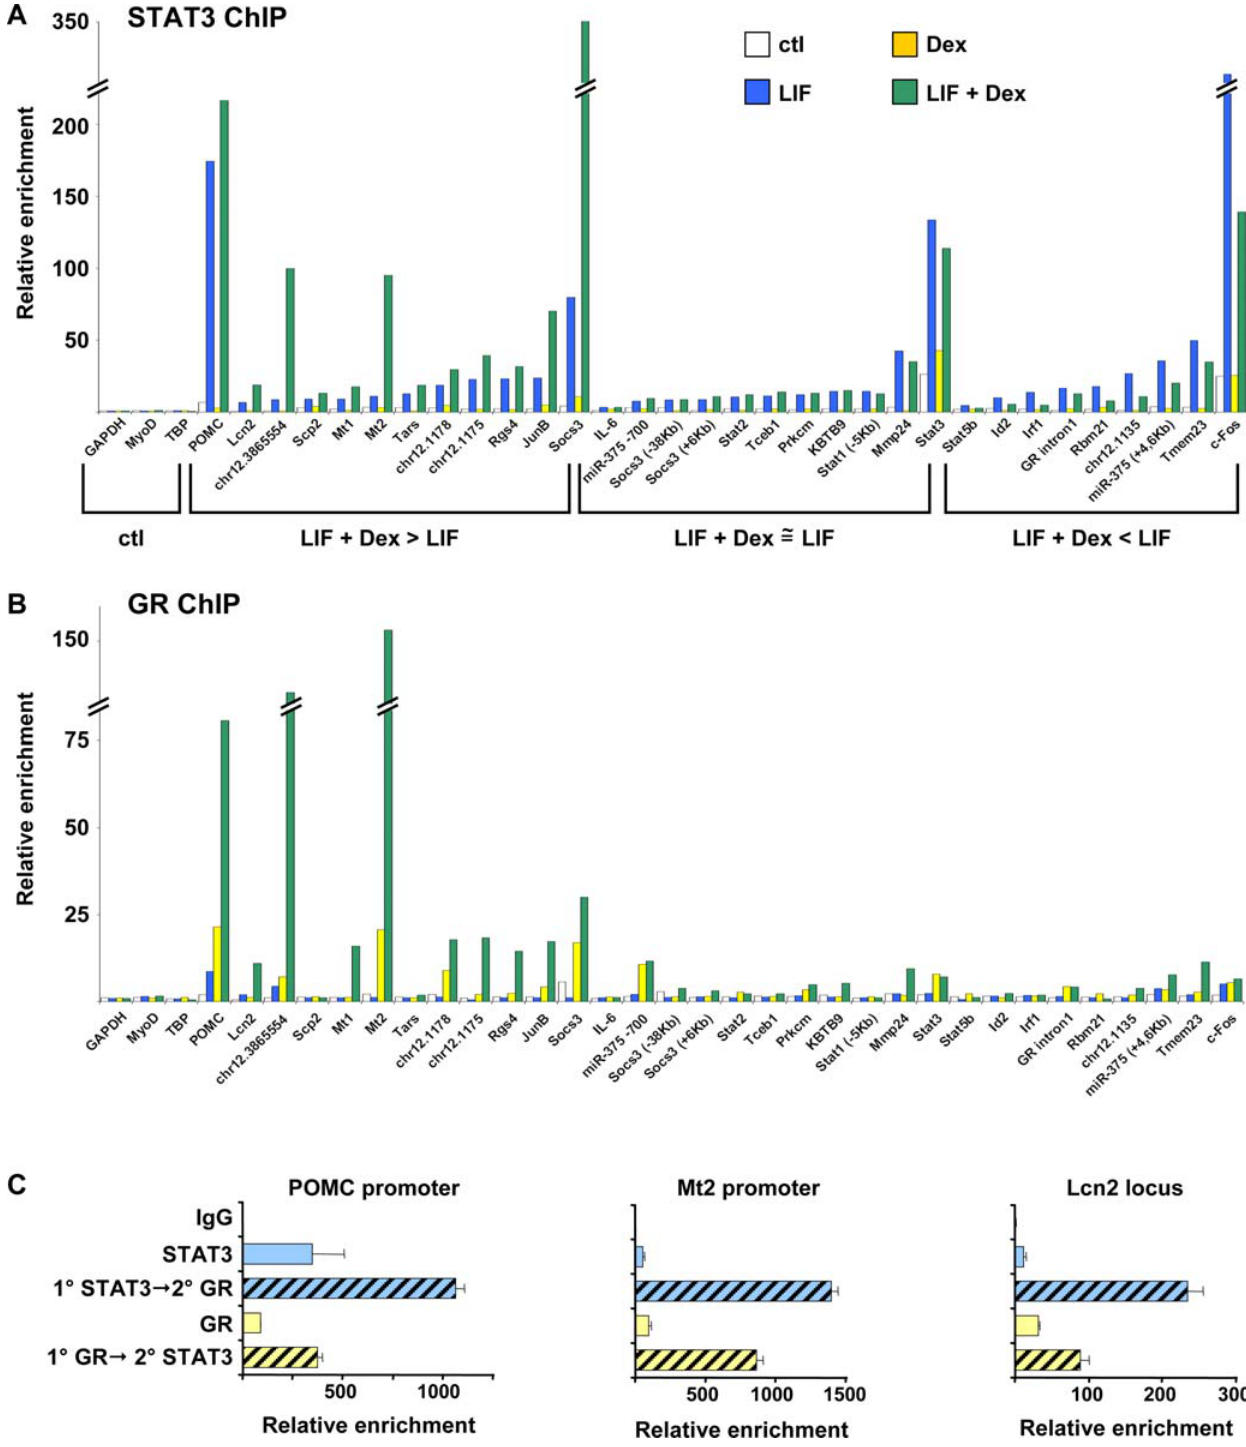
Figure 3. Potentiation of STAT3 and GR recruitment at a subset of LIF/STAT3 target genes. A) A group of 32 genomic STAT3 target sites and 3 control (ctl) loci ( Gapdh , Myod and Tbp ) were evaluated for STAT3 binding by QPCR analysis of ChIP performed on AtT-20 cells treated for 20 minutes with LIF (10 ng/ml), Dex (10 2 7 M), both or vehicle. Following analysis, genes were re-grouped for presentation in three classes: those for which STAT3 recruitment is greater ( $ 1.25 fold) in LIF + Dex than LIF-treated cells and those for which this is equal or smaller. B) GR ChIP performed on the same loci as for STAT3. C) Sequential ChIPs were performed for three loci on chromatin isolated from AtT-20 cells treated with LIF and Dex to confirm co-occupancy of STAT3 and GR on the same DNA fragments. Data are shown for single ChIP and for samples immunoprecipitated first with STAT3 and then GR antibody, and the reverse. In each case, data is presented as fold recruitment relative to the IgG sample and normalized by Gapdh as QPCR reference.